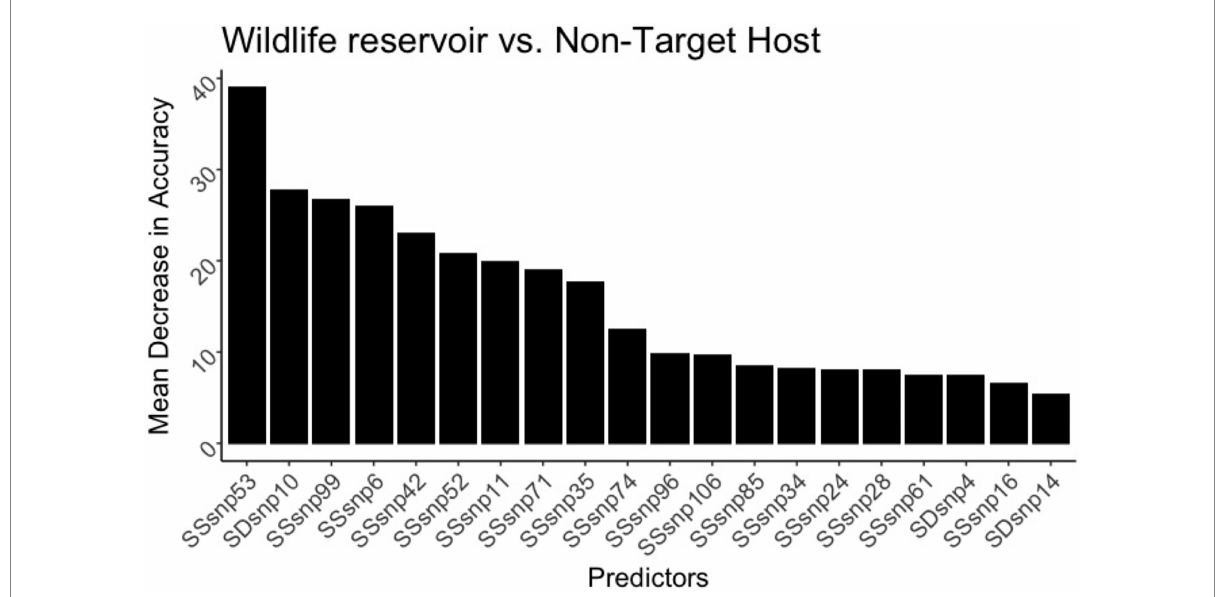
FIGURE 8 The 20 top predictors for the United Kingdom badger versus cattle random forest models. SNP evolution occurring in SSR53 is the top predictor in differentiating the species in the United Kingdom. SDR10 increased substantially in model importance, indicating its ability to differentiate badger from